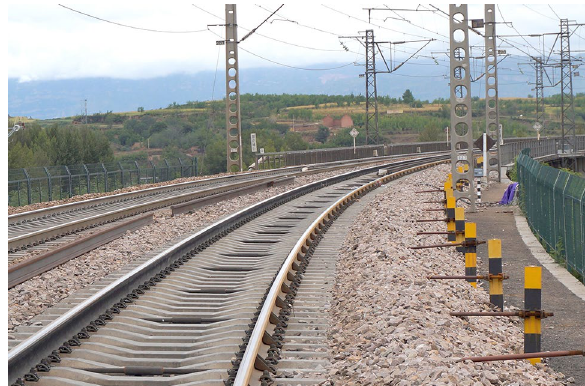
vide assistance to the researchers for the validation of their numerical models of the heavy freight train system.